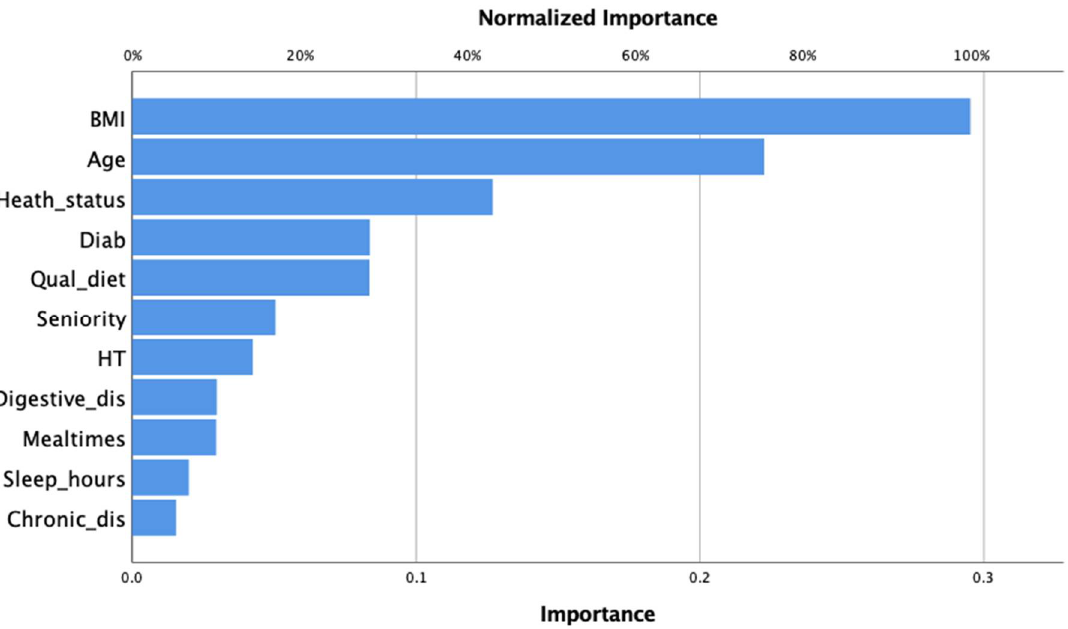
Figure 1. Importance of each factor related to BO computed by MLP-ANN in Mexican police officers.